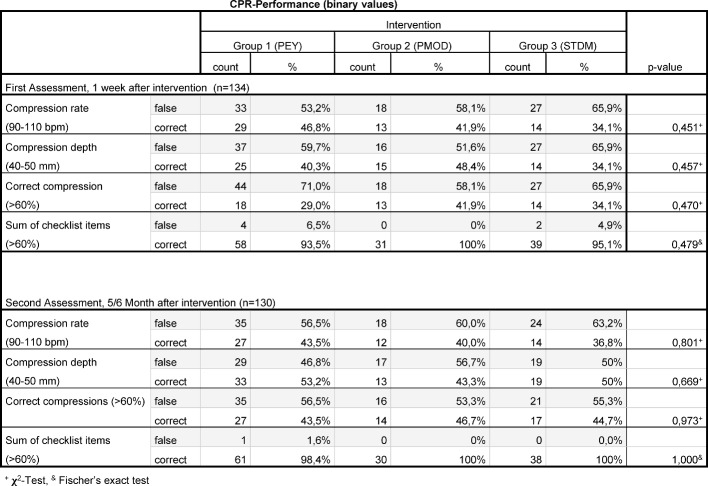
Binary CPR-Data